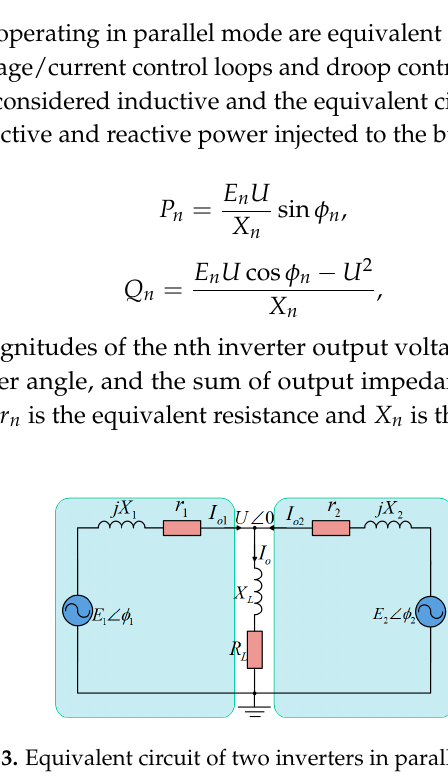
Figure 3. Equivalent circuit of two inverters in parallel